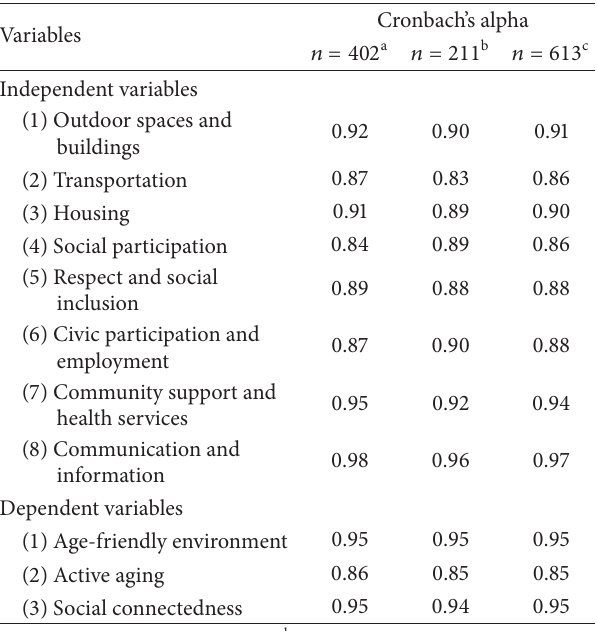
Table 2: Reliability test results of self-care adults and informal